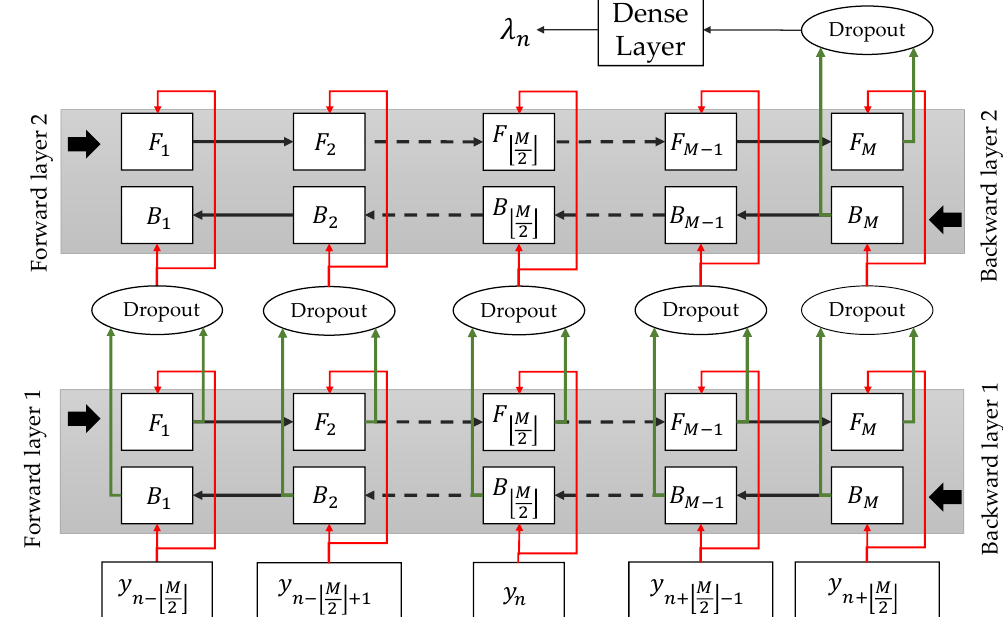
Figure 2. Unrolled RNN detector for an OFDM system ( M is